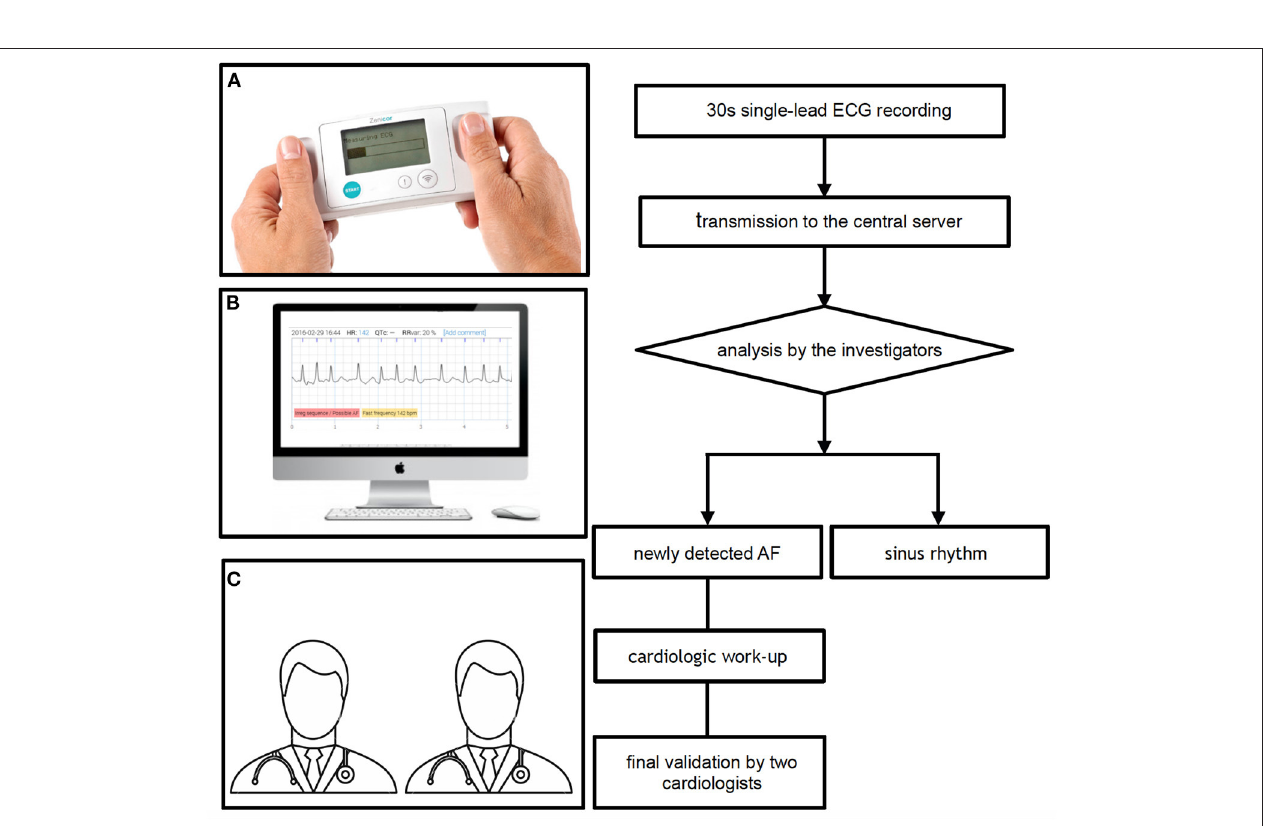
FIGURE 2 | Single-lead ECG recording and interpretation with the Zenicor device. (A) Thirty second single-lead ECG handheld device recording, (B) analysis of the ECG on the central server, and (C) final validation by two cardiologists in case of newly detected AF. AF, atrial fibrillation; ECG, electrocardiogram.